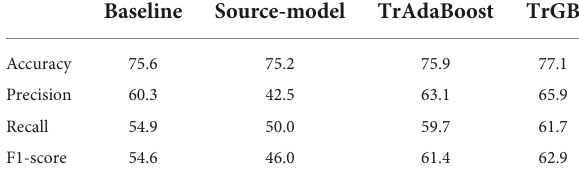
TABLE 6 CN/MCI classification scores for the baselines, source-model, TrAdaBoost, and TrGB scenarios using the multimodal data.